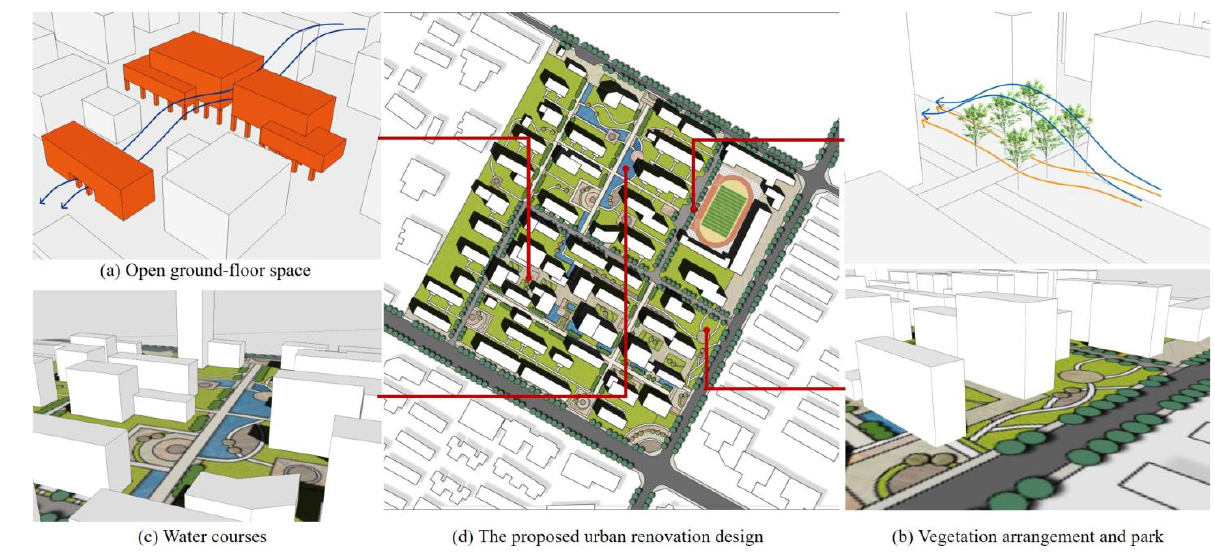
Figure 11. The final urban renovation design proposal in the research